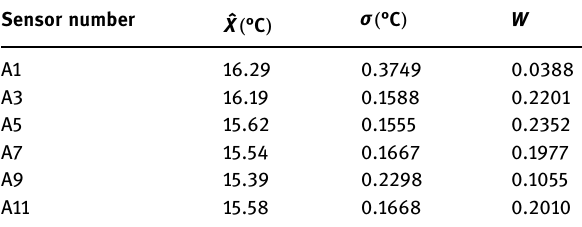
Table 5: Fusion results after the Grabbs criterion